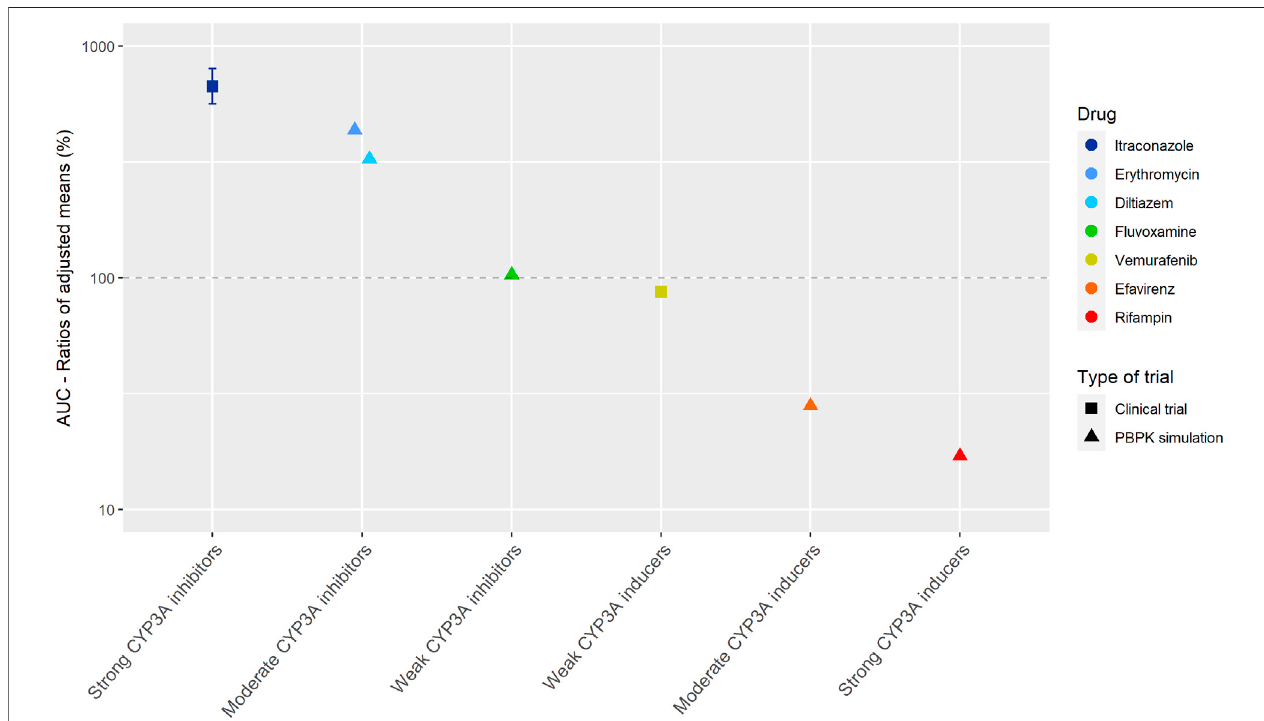
FIGURE2| OverviewoftheresultsfromDDIstudiesofcobimetinibcombinedwithCYP3Ainhibitorsandinducers.Thecolouredsymbolsrepresenttheincreaseor decreaseinAUCcausedbytheinteractingdrug,expressedasadjustedmean ± 90%con fi denceinterval(ifavailable).ThedashedlinerepresentsthebaselineAUC(Food and Drug Administration,